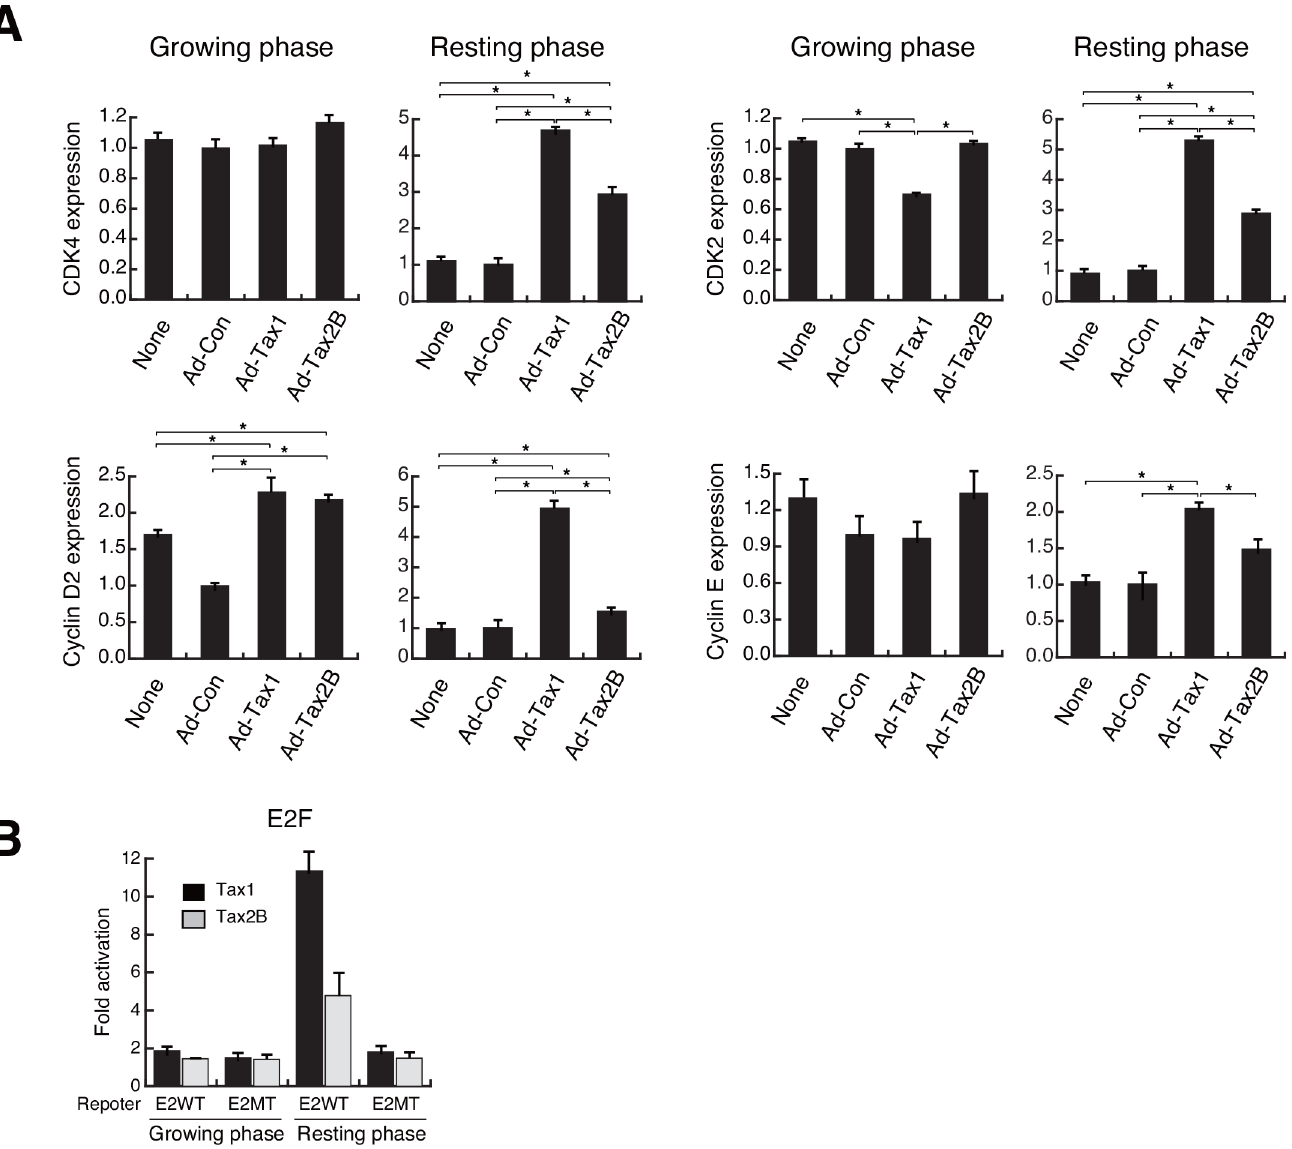
Fig 3. Induction of cell cycle regulatory genes by Tax1 in resting cells. (A) Growing or resting Kit 225 cells were infected with Ad-Tax1 or Ad-Tax2B. Cells were cultured for 72 h and harvested for RNA isolation. The levels of CDK4, cyclin D2, CDK2 and cyclin E mRNA were measured by qPCR. Values are shown as the means ± SE after normalization against 18 S rRNA content. * , p < 0.05. (B) Reporter plasmids carrying binding sites for the wild-type and point- mutated E2F were transfected into Kit 225 cells along with Tax1 and Tax2B expression plasmids (pMT-2Tax and pH β AP-r-1-neoTax2B, respectively). After 48 h of culture with or without IL-2, the cells were harvested for luciferase assay, which was subsequently normalized against protein content. Values are shown as fold activation relative to luciferase activity of cells with pH β AP-r-1-neo (means ±